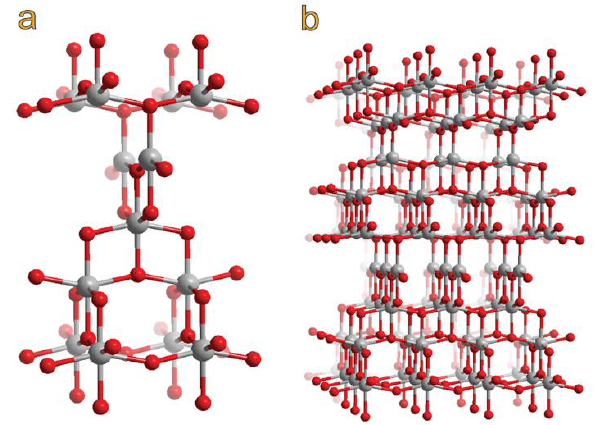
Figure A1. Anatase models optimized at the PBE + U level of theory: unit cell ( a ) and 3 × 3 × 2 supercell ( b ); oxygen atoms are red, titanium atoms are grey.